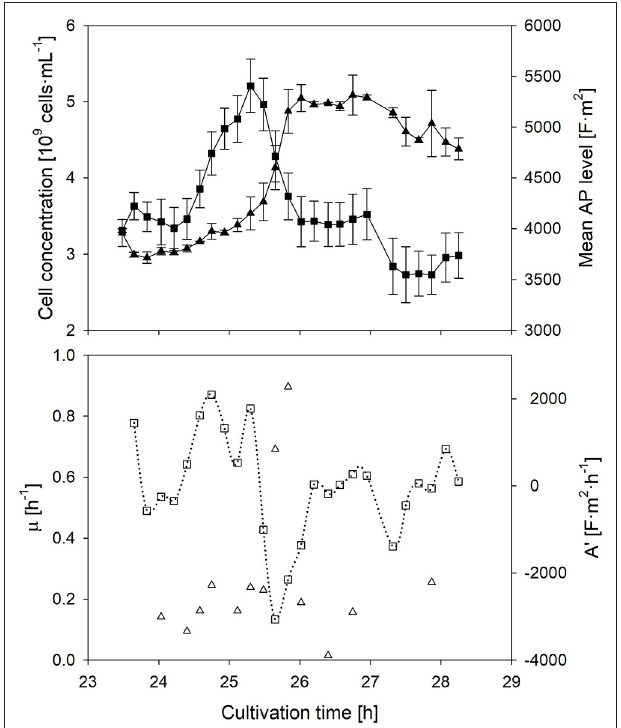
FIGURE 3 | Time course of the mean anisotropy of polarizability ( (cid:4) ), its first derivative ( (cid:3) ), cell concentration ( N ) and specific growth rate ( △ ) after a sudden substrate pulse after cells suffered 17h of starvation. Error bars represent the technical reproducibility of EloTrace with two biological replicates.